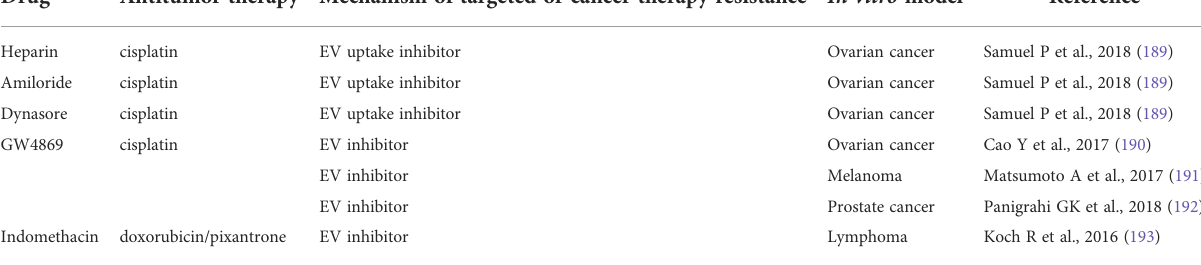
TABLE 2 Summary of the main anti-EV agents in cancer and cancer drug resistance in preclinical models. Drug Antitumor therapy Mechanism of targeted or cancer therapy resistance In vitro model